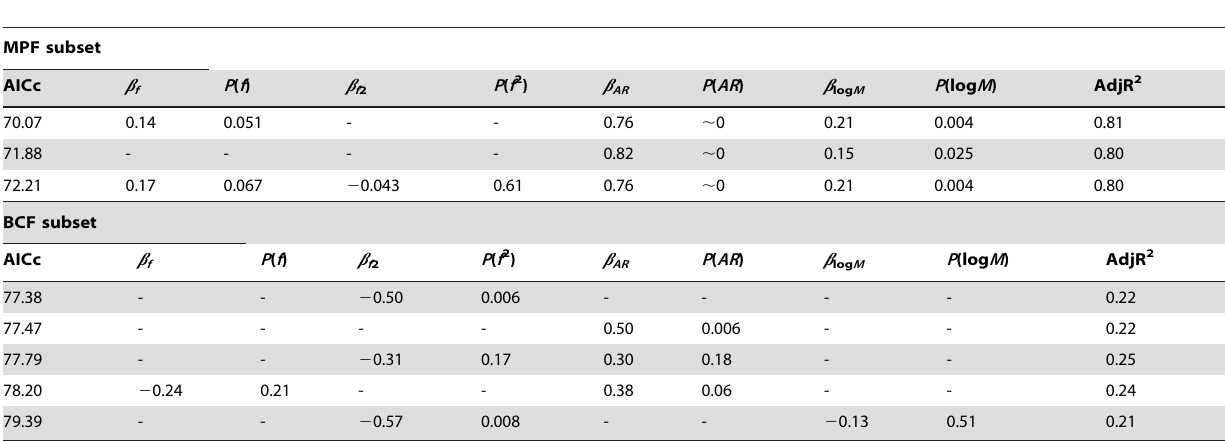
Table 3. Regression statistics of maximum prolonged-swimming speed on predictor